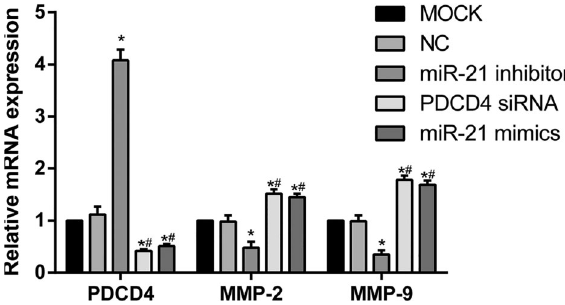
Figure 4. Programmed cell death 4 (PDCD4), matrix metallopro- teinase-2 (MMP-2) and matrix metalloproteinase-9 (MMP-9) mRNA